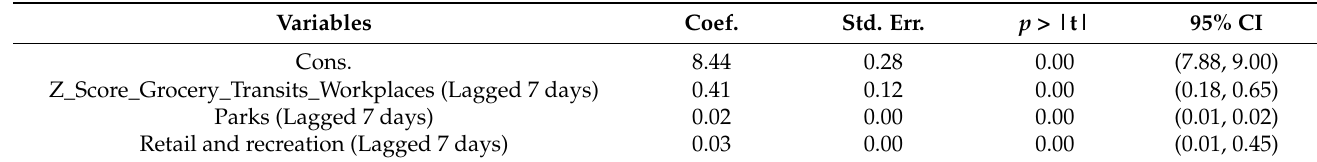
Table 4. Multiple linear regression analysis using daily confirmed case and mobility variables.